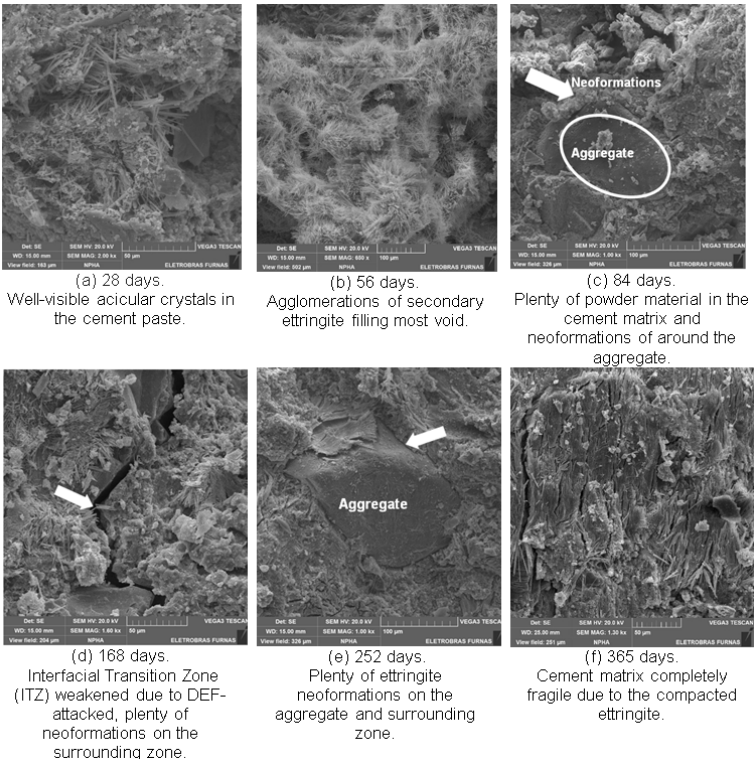
Figure 21. Micrographs of concrete with Type III cement.